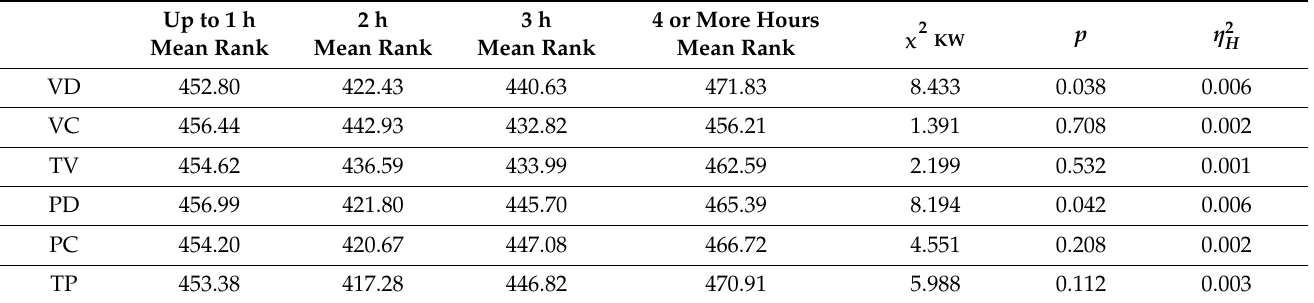
Table 4. Differential comparative analysis of victimization and perpetration, in relation to recreational time